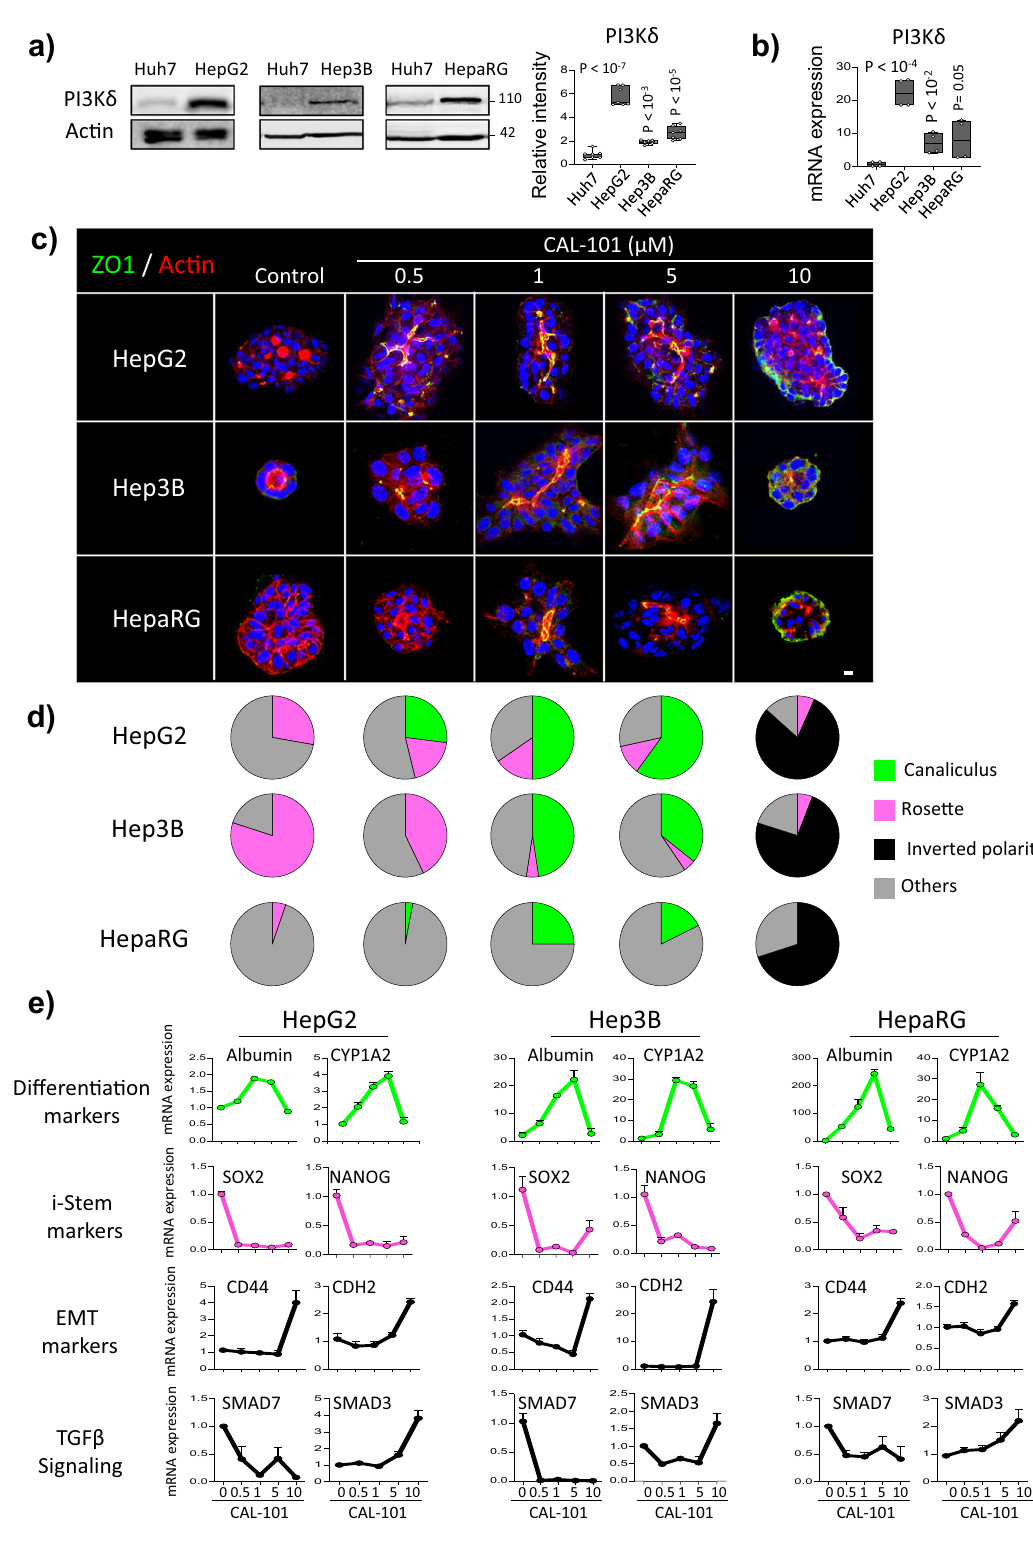
Fig. 6 Inhibition of PI3K δ activity improves canaliculus formation and differentiation in HepG2, Hep3B and HepaRG cells associated with the regulation of EMT and stemness markers. a Immunoblot analysis of PI3K δ protein level in Huh7, HepG2, Hep3B and HepaRG with the quanti fi cation of its relative intensity (right, n = 3 experiments). b RT-qPCR analysis of PI3K δ expression in Huh7, HepG2, Hep3B and HepaRG cells; RPLP0 was used as the housekeeping gene for normalization. c Immuno fl uorescence staining for ZO-1 (green), actin micro fi laments using phalloidin (red) and nuclei (blue) in HepG2, Hep3B and HepaRG cells plated in 3D cultures for 6 days and treated with the PI3K δ speci fi c inhibitor (CAL-101) at different doses. Scale bar: 10 µ m d Quanti fi cation of the percentage of the different phenotypes seen in the conditions above ( n = 40 organoids). e RT-qPCR analysis of several markers expression in HepG2, Hep3B and HepaRG cells plated in 3D culture and treated with different doses of CAL-101 for 6 days in two independent experiments performed in duplicate; RPLP0 was used as the housekeeping gene for normalization. All values are expressed as mean ±